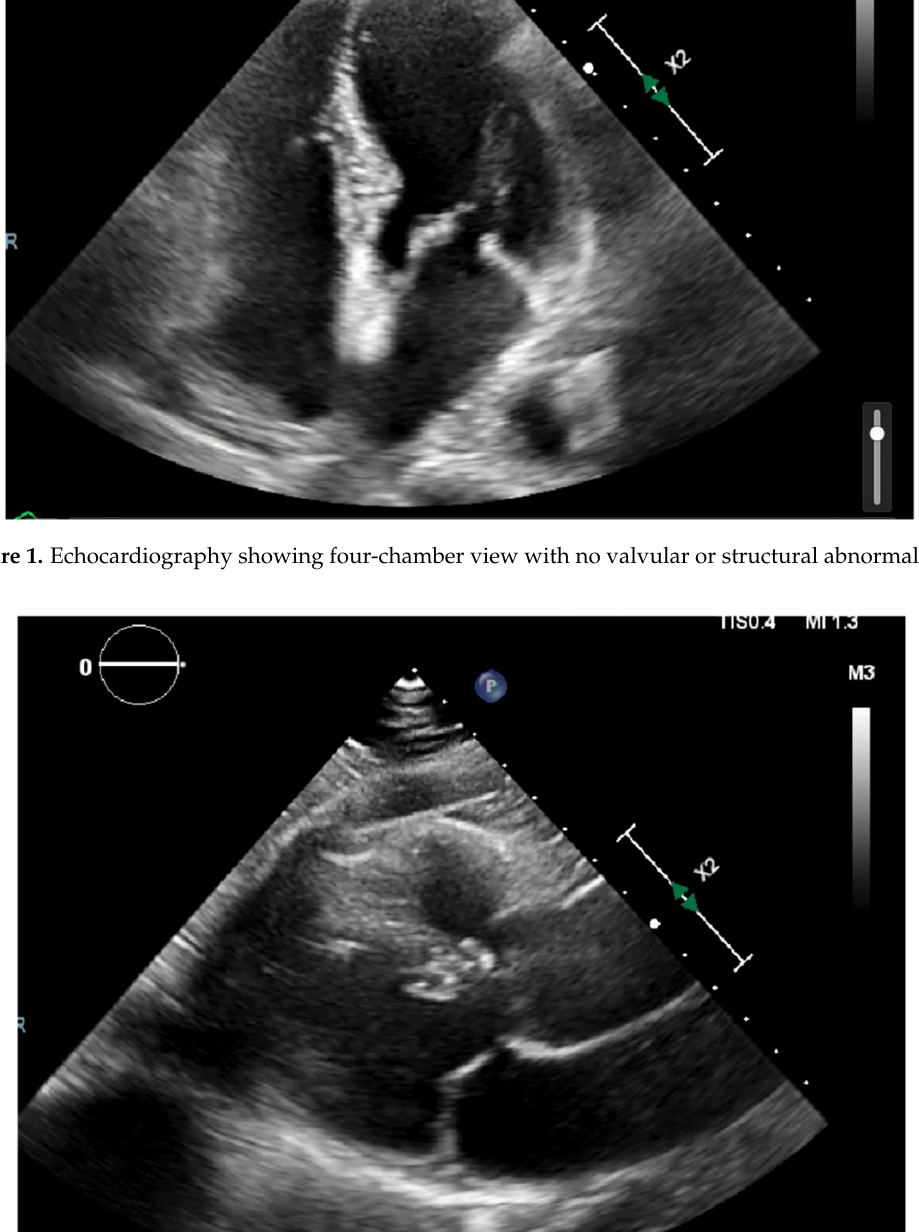
Figure 3. EKG showing sinus tachycardia with heart rate of 101 bpm. 3. Discussion Most patients with inappropriate sinus tachycardia are young and female. Among a single-center cohort of 305 patients with inappropriate sinus tachycardia seen between 1998 and 2018, 92% were female, with an average age of 33 years [8]. Affected patients have an elevated resting heart rate and/or an exaggerated heart rate response to exercise that is out of proportion to their body’s physiological needs; many patients have both.